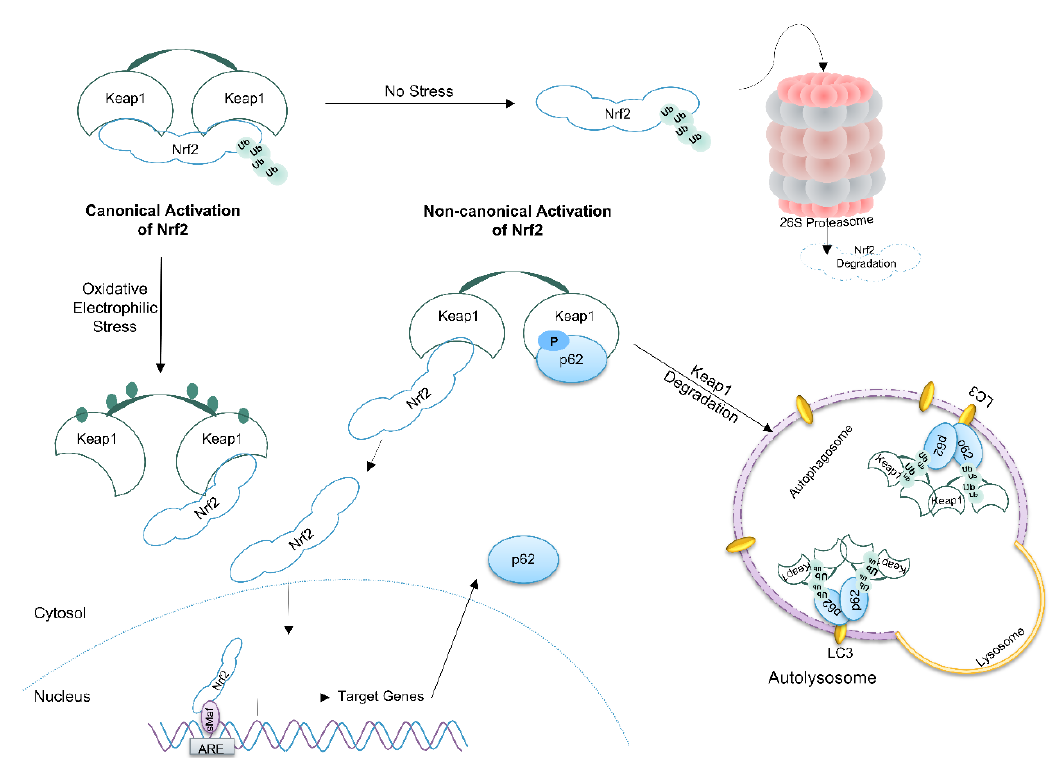
Figure 2. Non-canonical Nrf2 activation by p62. Under non-stressed conditions, the cytoprotective transcription factor Nrf2 is continuously degraded by the proteasome upon Keap1-mediated ubiquitination. Oxidation of regulatory cysteine residues of Keap1 in situations with oxidative and electrophilic stress inhibits Keap1 and ubiquitination of Nrf2 causing canonical Nrf2 activation and induction of target gene expression. When p62 is phosphorylated at Ser349, it binds to Keap1 causing its autophagic degradation. Afterwards, Nrf2 is free to translocate to the nucleus and to induce target gene expression (non-canonical Nrf2 activation) [79].